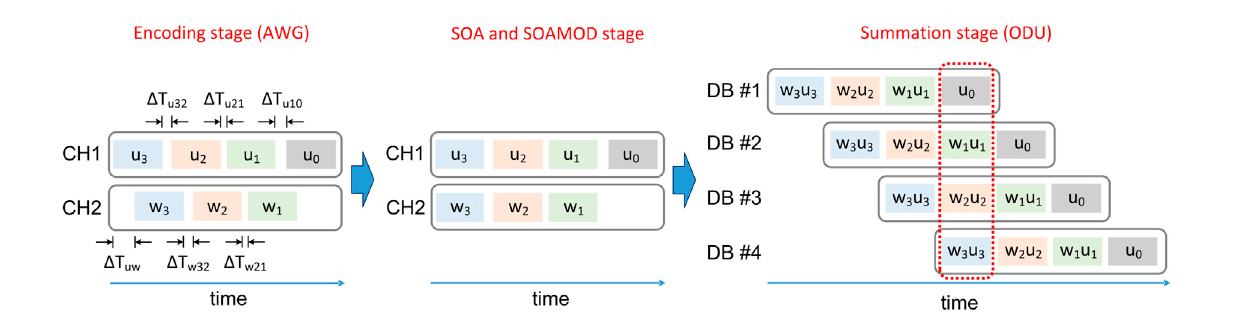
FIGURE 4 Schematic diagram of the time-multiplexing encoding and the coincidence detection at the ODU output. The temporal distances between the encoded input u i (CH1) and weight w i (CH2) data sets are de fi ned so that there is a prede fi ned time window for the ODU summation stage in which the different, individual signals that propagate along the dendritic branches DB are temporally aligned and